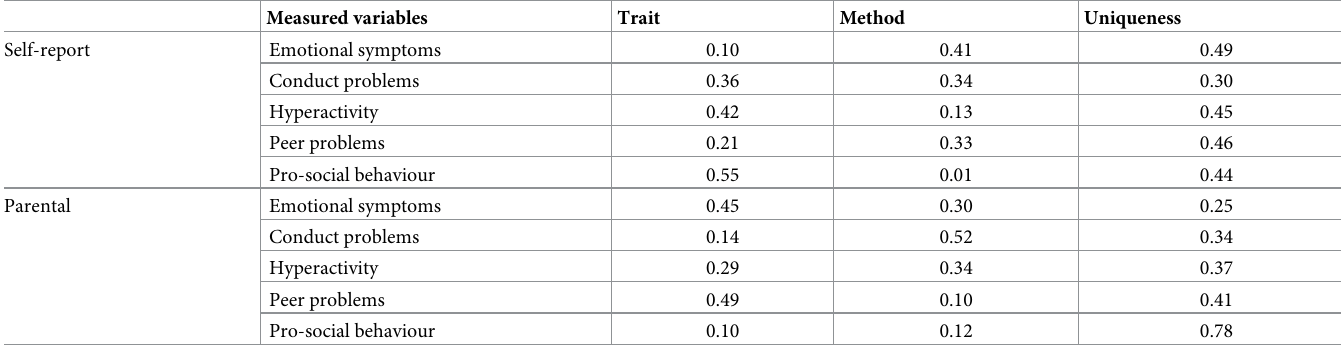
Table 4. Trait and method variance components for the MTMM